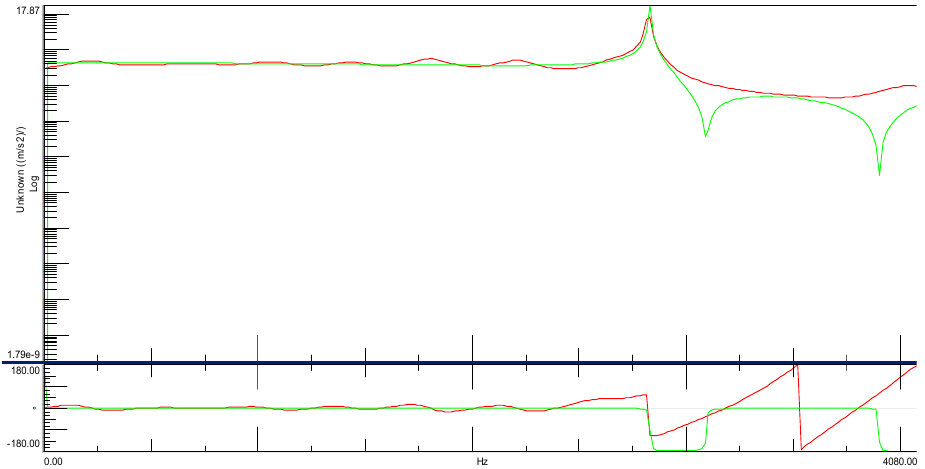
Figure 18. Verification of the measured spectral transition function FRF with its synthesized form.